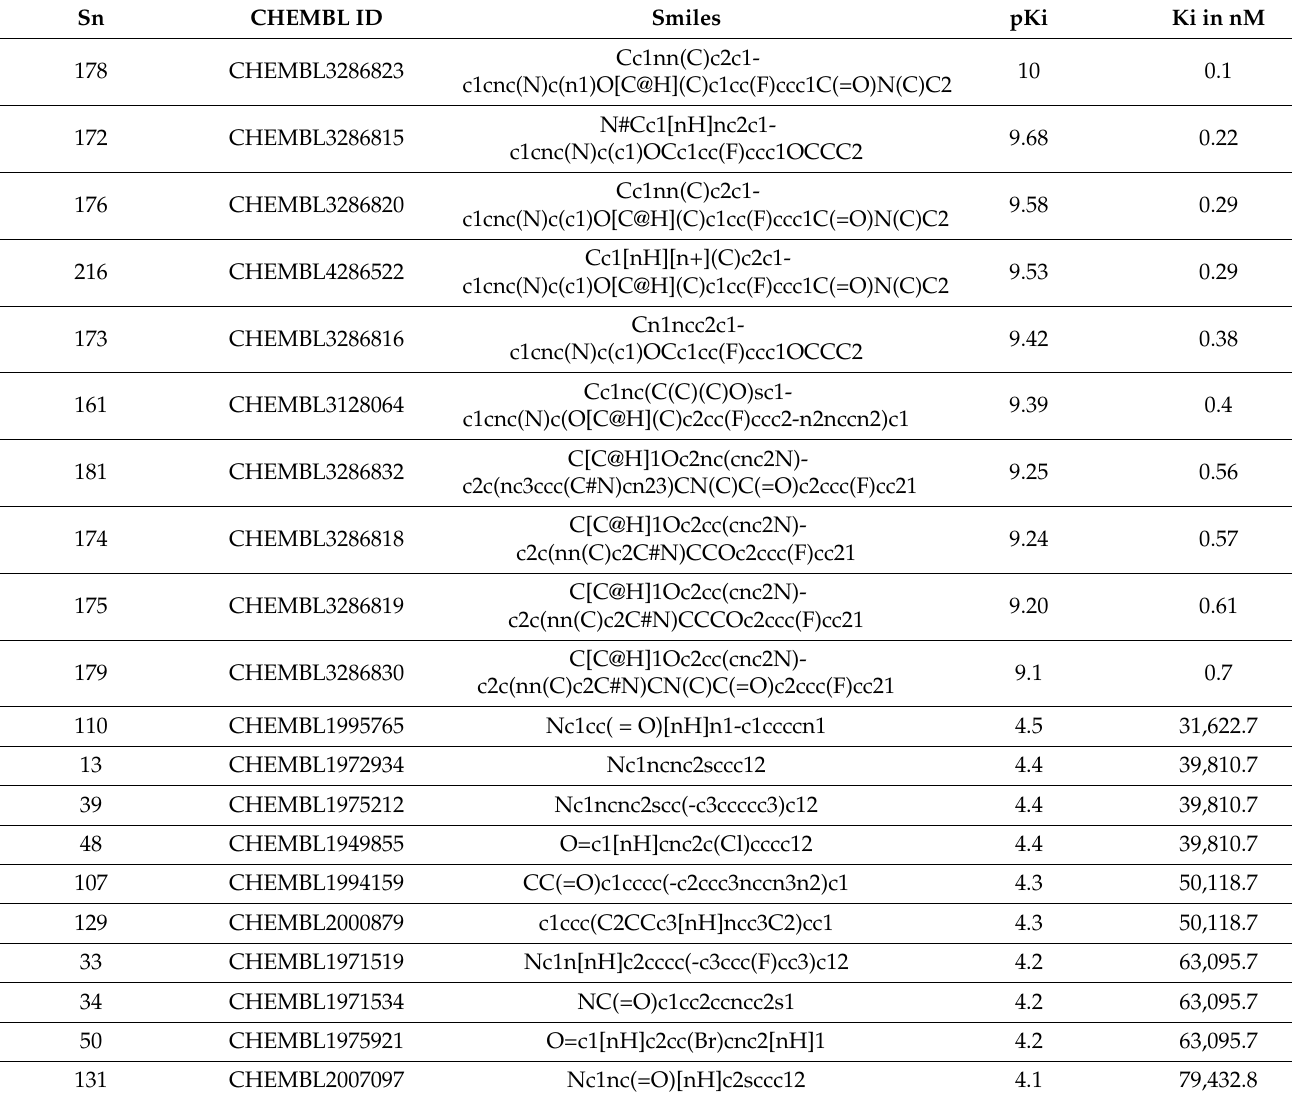
Table 5. Presentation of Serial number, ChEMBL ID, Smiles, pKi and Ki value of 10 most active and 10 least active molecules in the dataset as representative examples